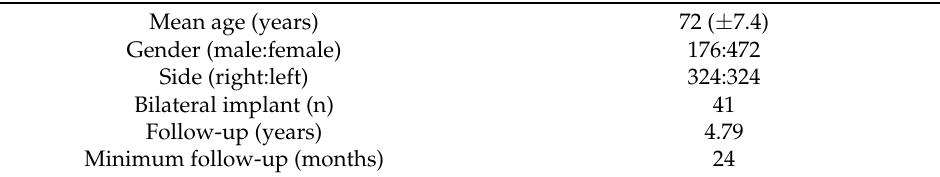
Table 1. Patients’ general